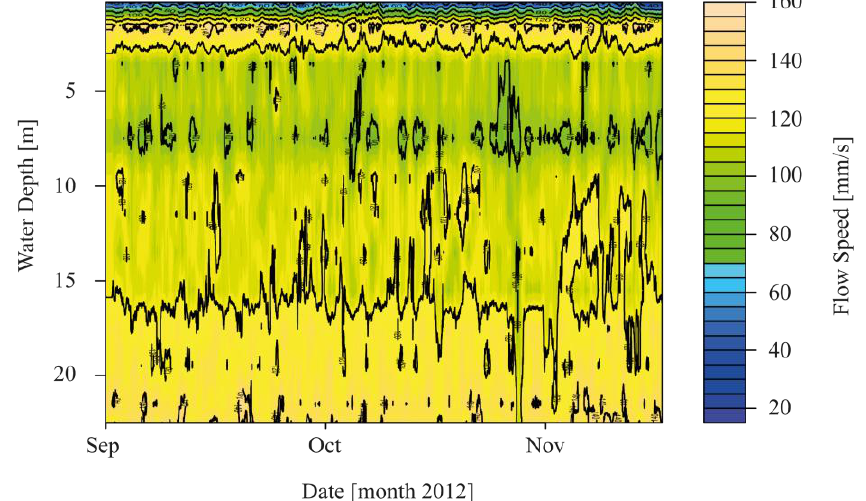
Figure 9. Interpolated flow speed (fs) from ADCP and current meter data at the buoy